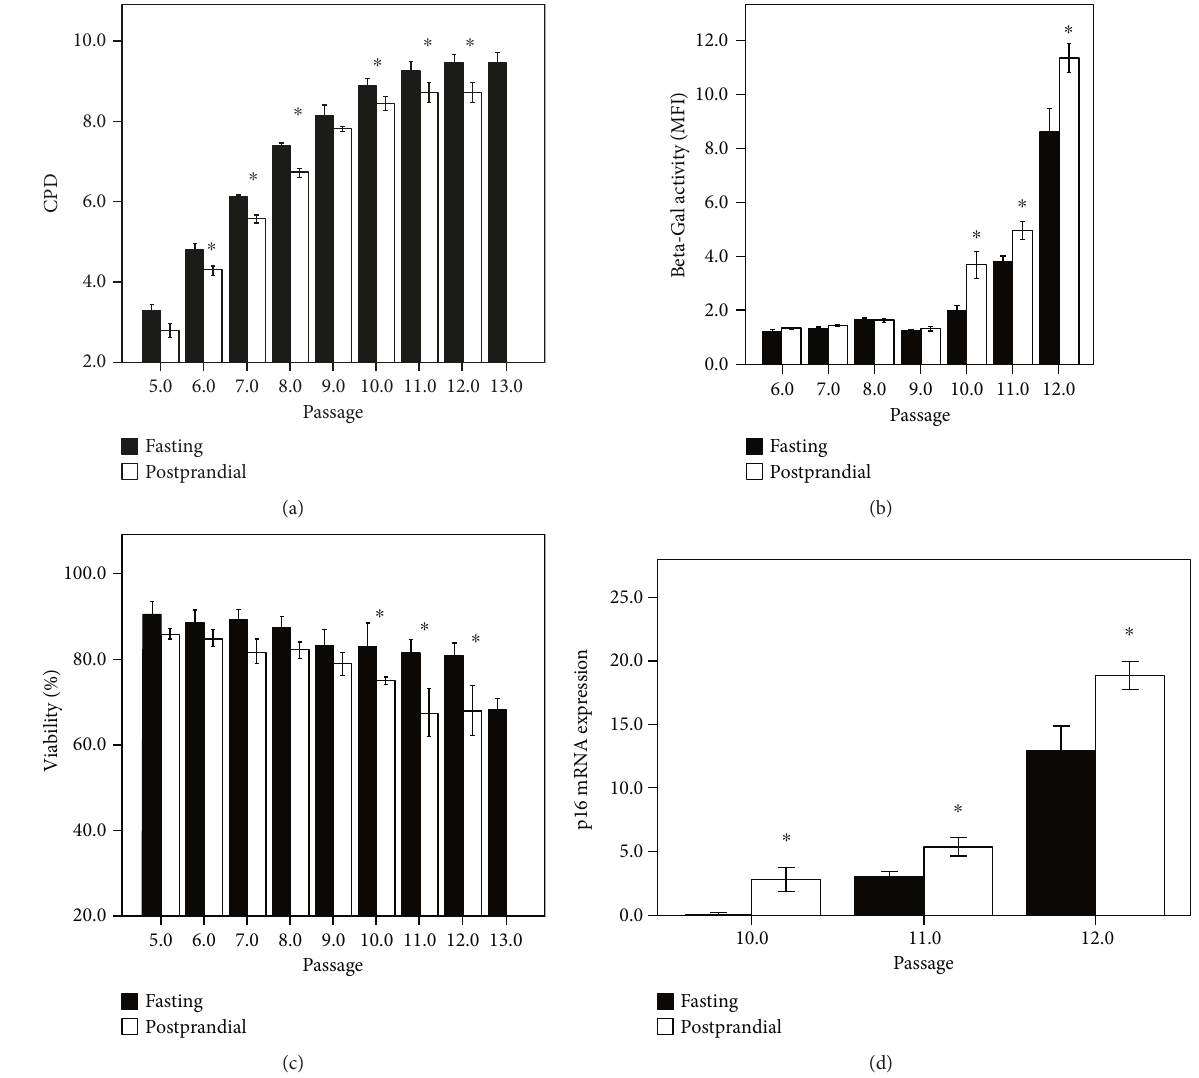
Figure 6: The e ff ect of culture with postprandial serum (2 times per day for 4 h) compared to fasting serum (2 times per day for 4h) on growth and senescence of HCAECs. Postprandial serum used for these experiments was obtained from adult volunteers after the pork meat meals. All data are mean ± SEM for n = 4 – 6 independent cell populations for each condition (fasting serum and postprandial). (a) Cumulative population doubling (CPD) was calculated using the formula 3.32 ∗ (log10 F − log10 I ) over consecutive population doublings. (b) Senescence-associated β -galactosidase (SA- β -gal) activity for cells grouped by passage number and treatment as indicated. (c) Viability for cells grouped by passage number and treatment as indicated. (d) p16 expression after passage 9 for cells grouped by passage number and treatment as indicated. Data are means with error bars showing SEM. ∗ p < 0 05 compared to fasting